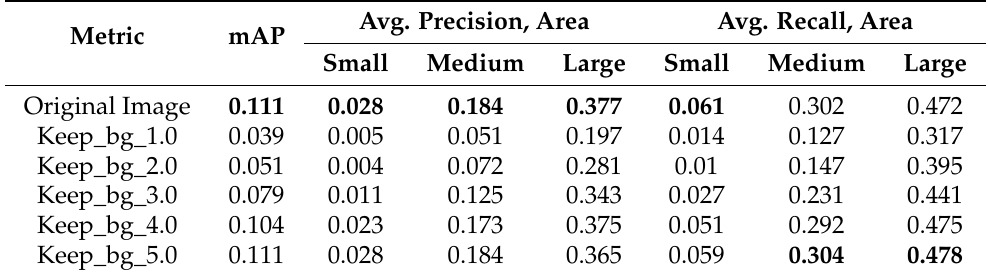
Figure 8. The original image and the counterparts but cropped part of the background, keep_bg_ k means to keep the background k times the area around the target. ( a ) Original image. ( b ) Keep five times the background. ( c ) Keep three times the background. ( d ) Keep one times the background (equivalent to the ground truth of target objects). Table 1. The influences of area cropping on object detection performance. Bold font indicates the best results.